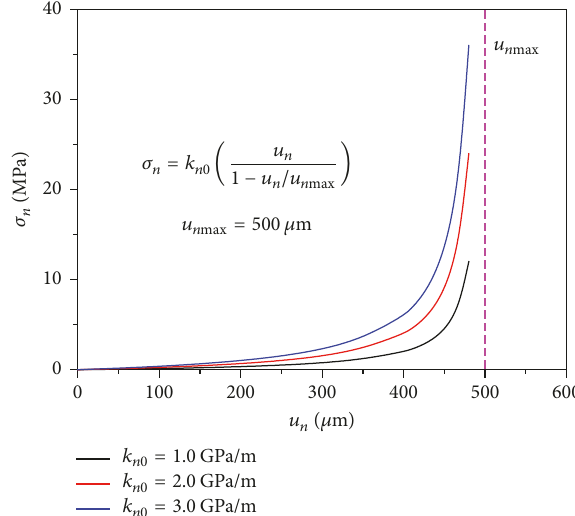
Figure 6: Relationships between Re 𝑐 and 𝑢 𝑠 based on the data replotted from Rong et al. ([100], Figure 9 ).